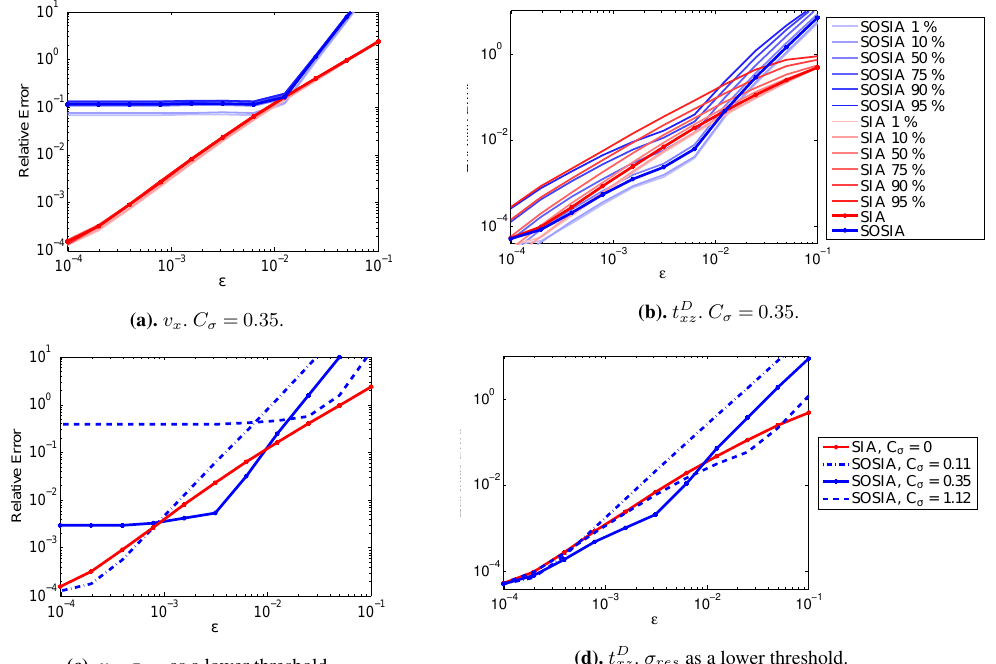
Fig. 2. Relative error of horizontal velocity v x and vertical shear stress t D xz with σ res = C σ ρg [ H ] (cid:15) for both SIA (red) and SOSIA (blue). Thick lines show the error measured over the whole domain and the thin lines in the upper two panels show the errors measured over horizontal layers.